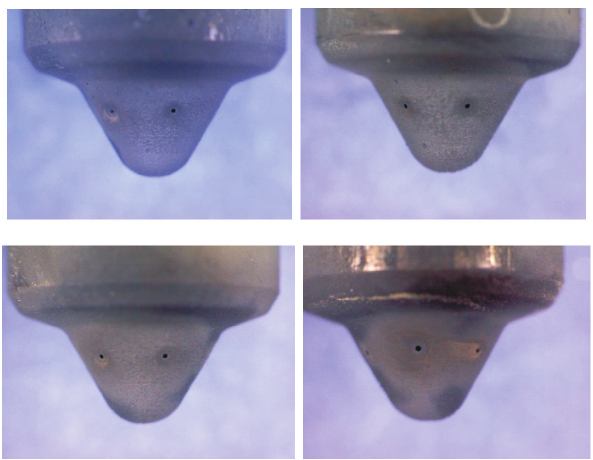
Fig. 9. View of the injector nozzles of the PSA DW10 engine after the test for the CEC DF-79-07/7 reference fuel containing 1 mg/kg Zn